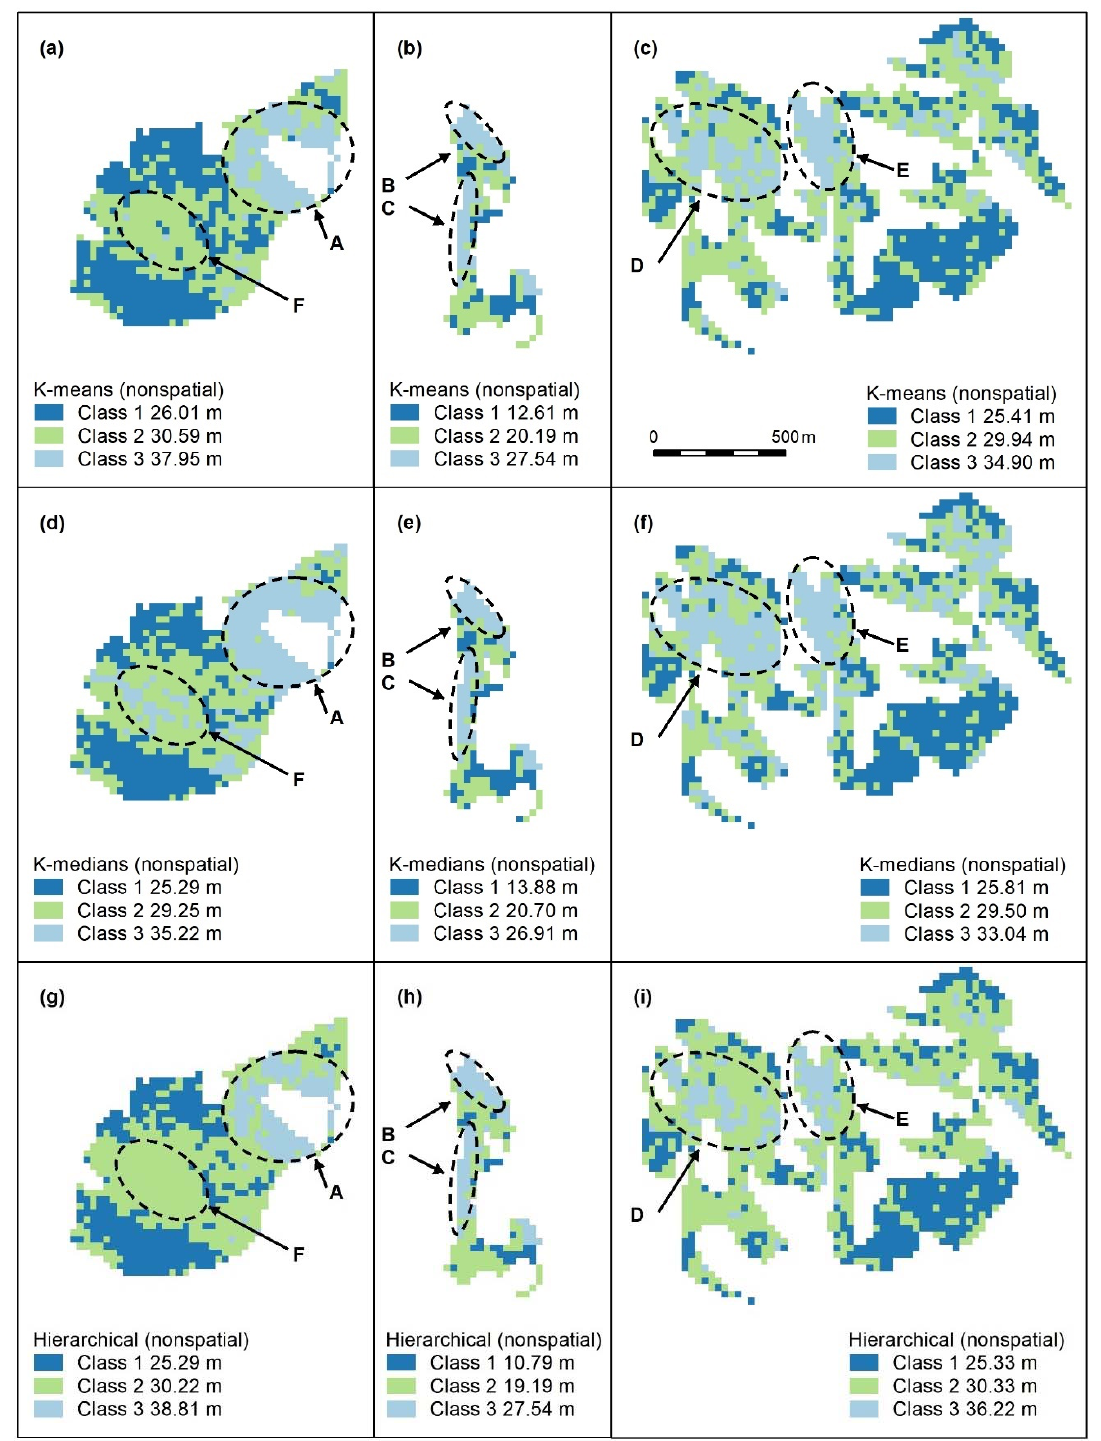
Figure A5. Nonspatial algorithm maps (K-means, a – c ; K-medians, d – f ; nonspatial hierarchical, g – i ) with 3 classes. Letters A–F indicate areas of higher canopy. K-medians ( d – f ) best captures features A, D, C, all algorithms capture B and C. No algorithm adequately captures F, the unmapped area of Eucalyptus tereticornis . Panel scores: K-means = 12, K-medians = 16, and Hierarchical = 11.